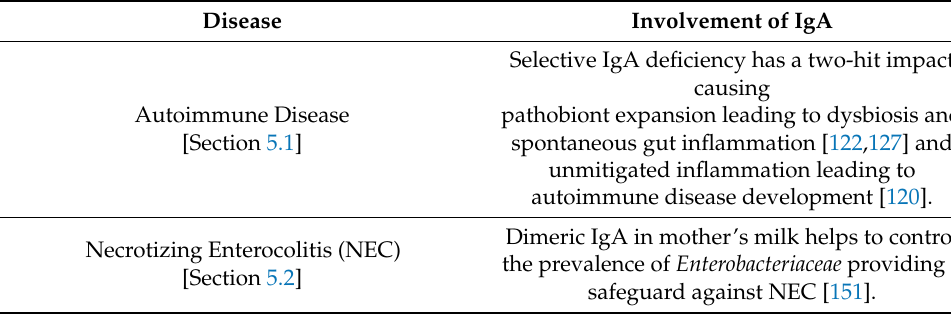
Table 1. IgA Involvement in Various